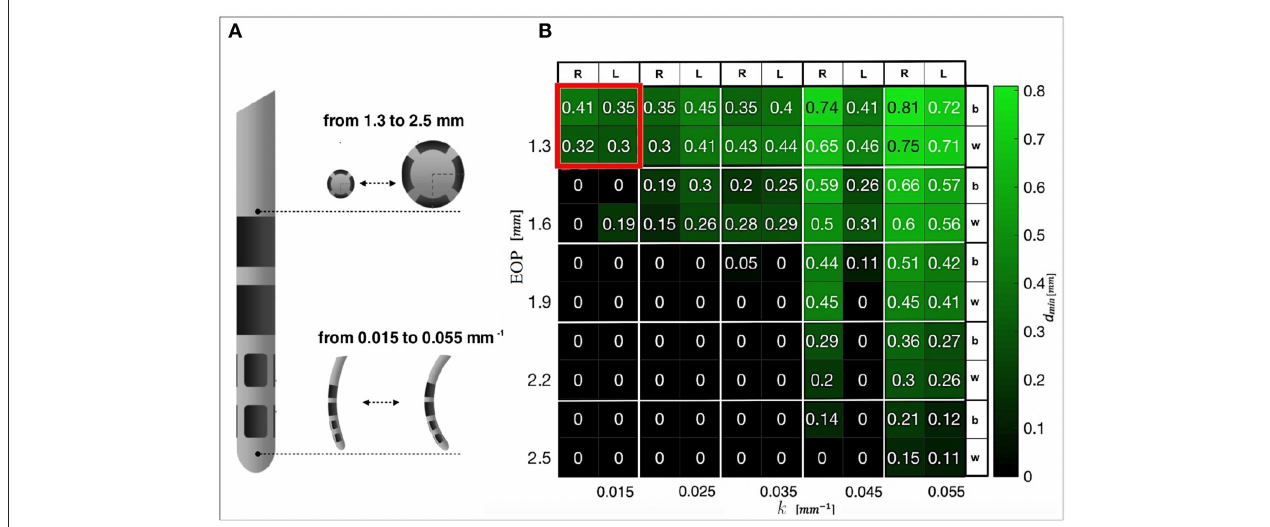
FIGURE 4 | (A) DBS electrode prototype, in which the tip that actually releases the stimulation is shown. Examples of progressive increase in diameter and curvature are presented. (B) Heatmap representing the minimal distances from AOs obtained when differently designed CTs reach the anterior STN. The best (b) and worst (w) results for the left (L) and right (R) hemispheres are displayed. In red, the constrains that we selected for successive tests are